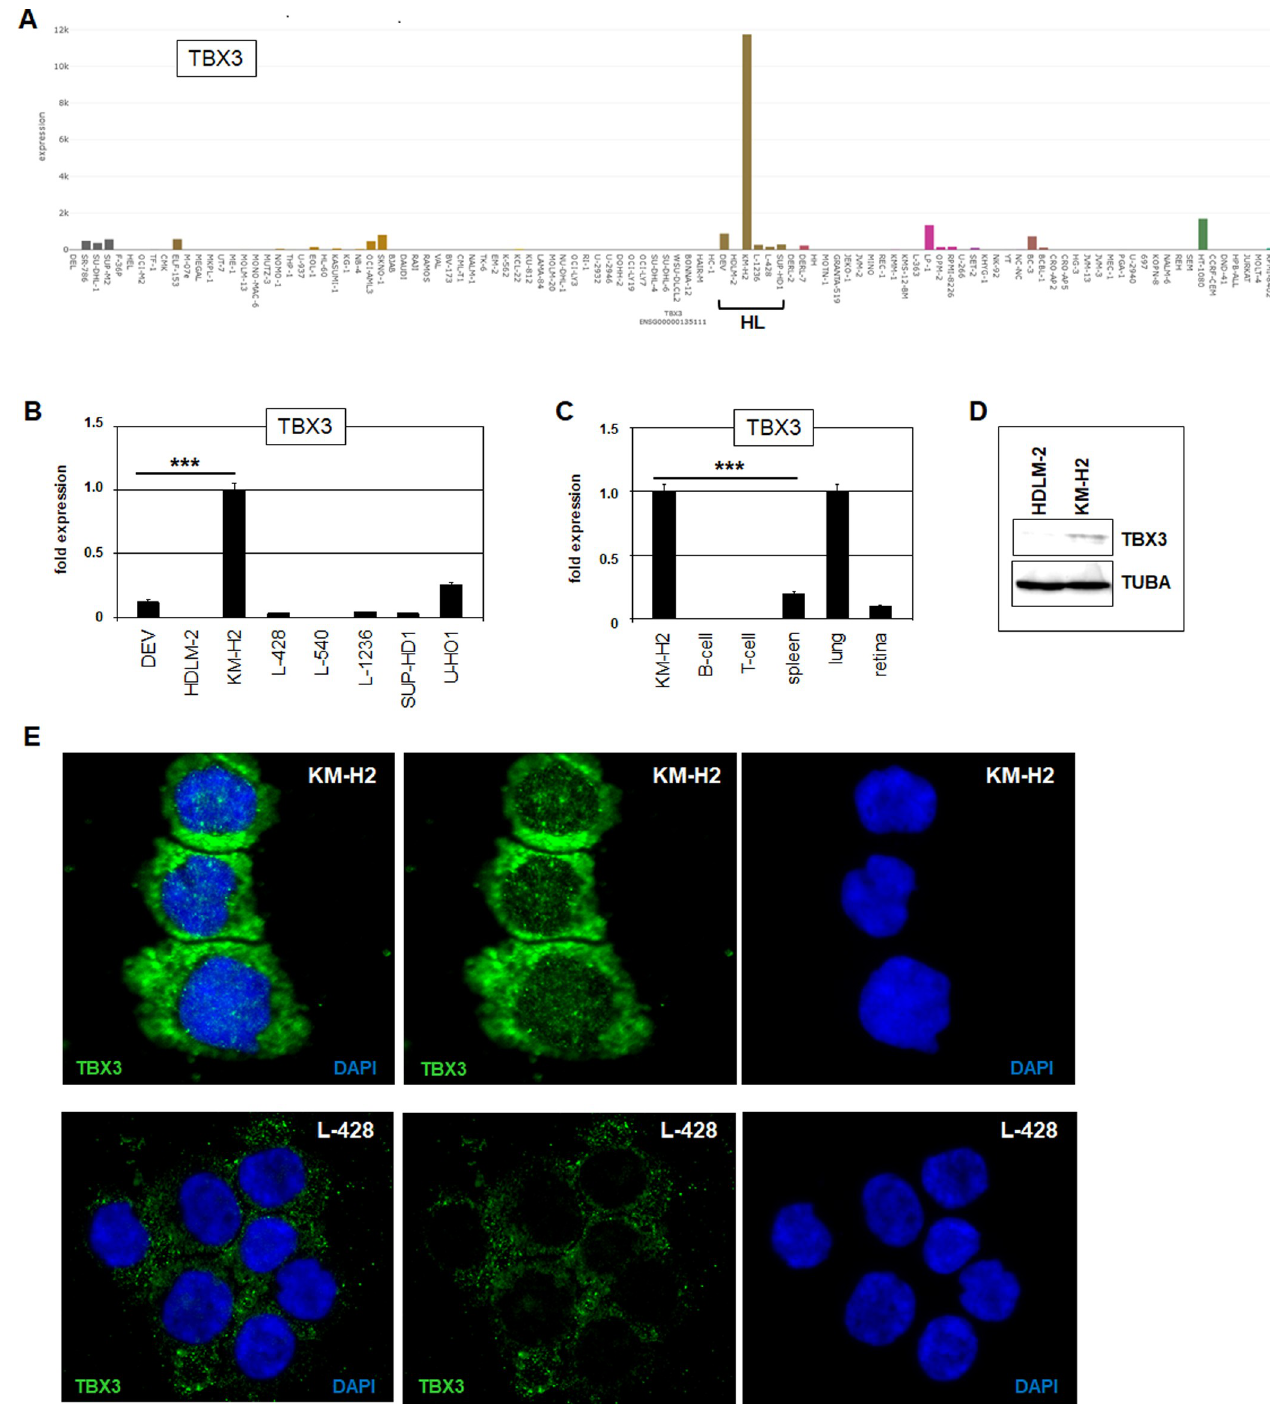
Fig 2. TBX3 and TBX5 expression in HL cell lines. (A) RNA-seq data show expression levels of TBX3 in 100 leukemia/lymphoma cell lines using dataset E-MTAB-7721. Note the singularly high transcript levels in HL cell line KM-H2. HL cell lines are indicated. (B) RQ-PCR analysis of TBX3 in HL cell lines, confirming elevated expression in KM-H2. (C) RQ-PCR analysis of TBX3 in KM-H2 in comparison to primary samples derived from B-cells, T-cells, spleen, lung and retina. (D) Western blot analysis of TBX3 in HL cell lines shows TBX3 expression at the protein level in KM-H2. (E) Immuno-fluorescence microscopy of KM-H2 (above) and L-428 cells (below) using TBX3 antibody (green) and nuclear counterstain DAPI (blue).